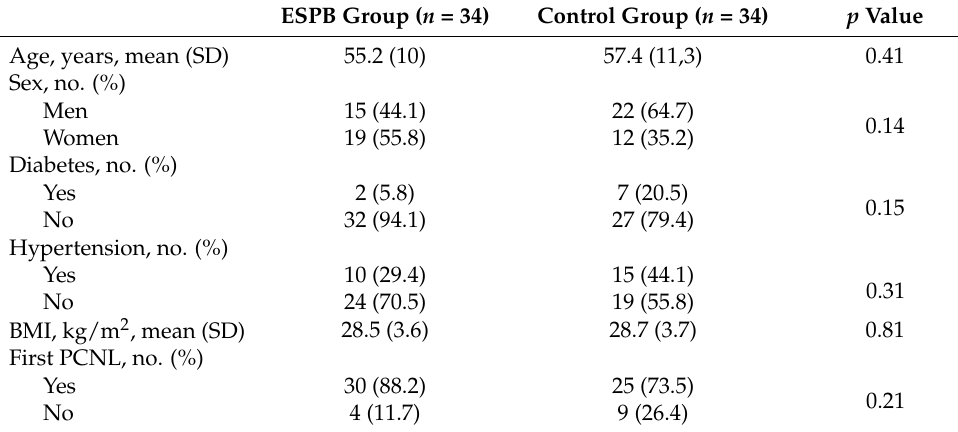
Table 1. Demographic characteristics of the analyzed groups. BMI, body mass index; PCNL, percuta- neous